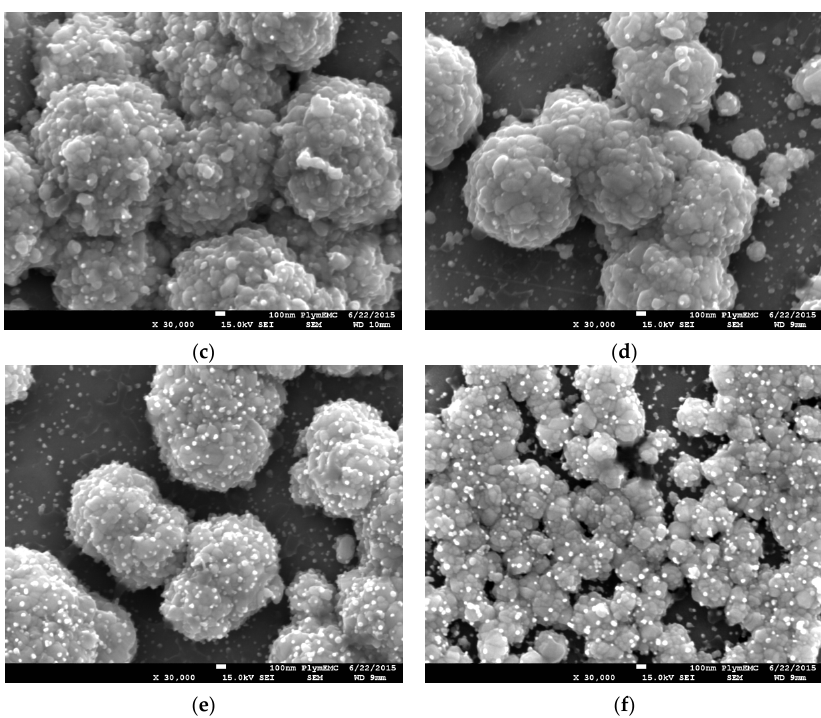
Figure 3. SEM micrographs of deposited particles at ×30,000 magnification. The brighter tiny particles are identified as pure silver nanoparticles, with the globules being Ag–PTFE mixture. ( a ) DCP with